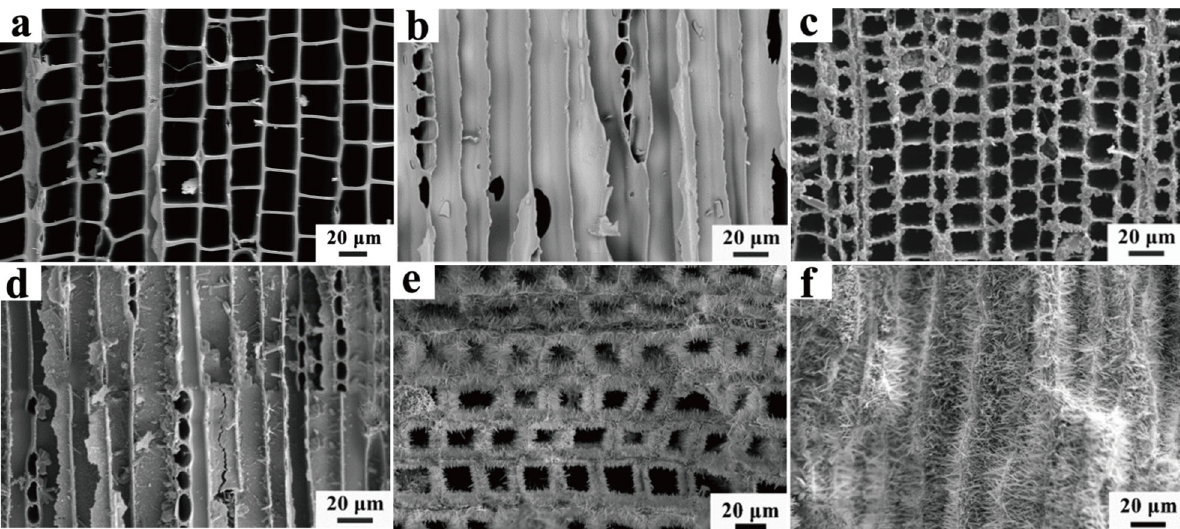
Fig. 2 Microstructures of the C B -template and the anisotropic bio-Si 3 N 4 ceramics after sintering at 1750 ℃ for 4 h. Corresponding (a) top-view and (b) cross-section SEM images of the C B -template; (c, d) SEM images of Si 3 N 4 ceramics obtained by the C B -template; (e, f) SEM images of Si 3 N 4 ceramics obtained by the C B -template coating with Y 2 O 3 additives.